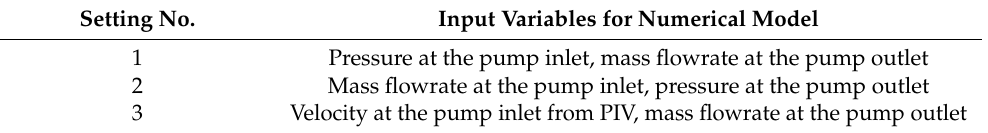
Table 1. Setting input parameters of numerical simulations. Setting